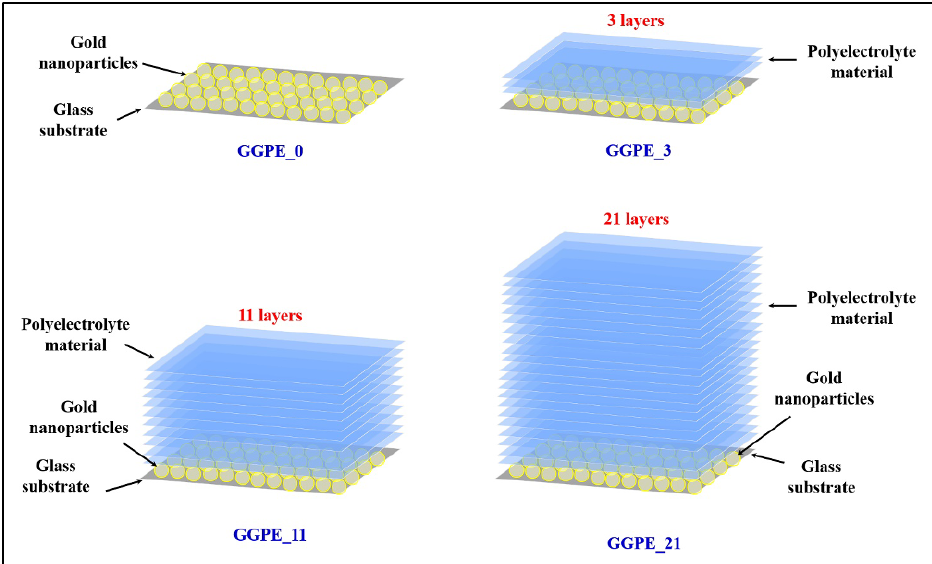
Figure 1. Schematic view of the four samples: GGPE 0 (glass substrate/GNPs), GGPE 3 (glass sub- strate/GNPs/3 layers of PE material), GGPE 11 (glass substrate/GNPs/11 layers of PE material), and GGPE 21 (glass substrate/GNPs/21 layer of PE